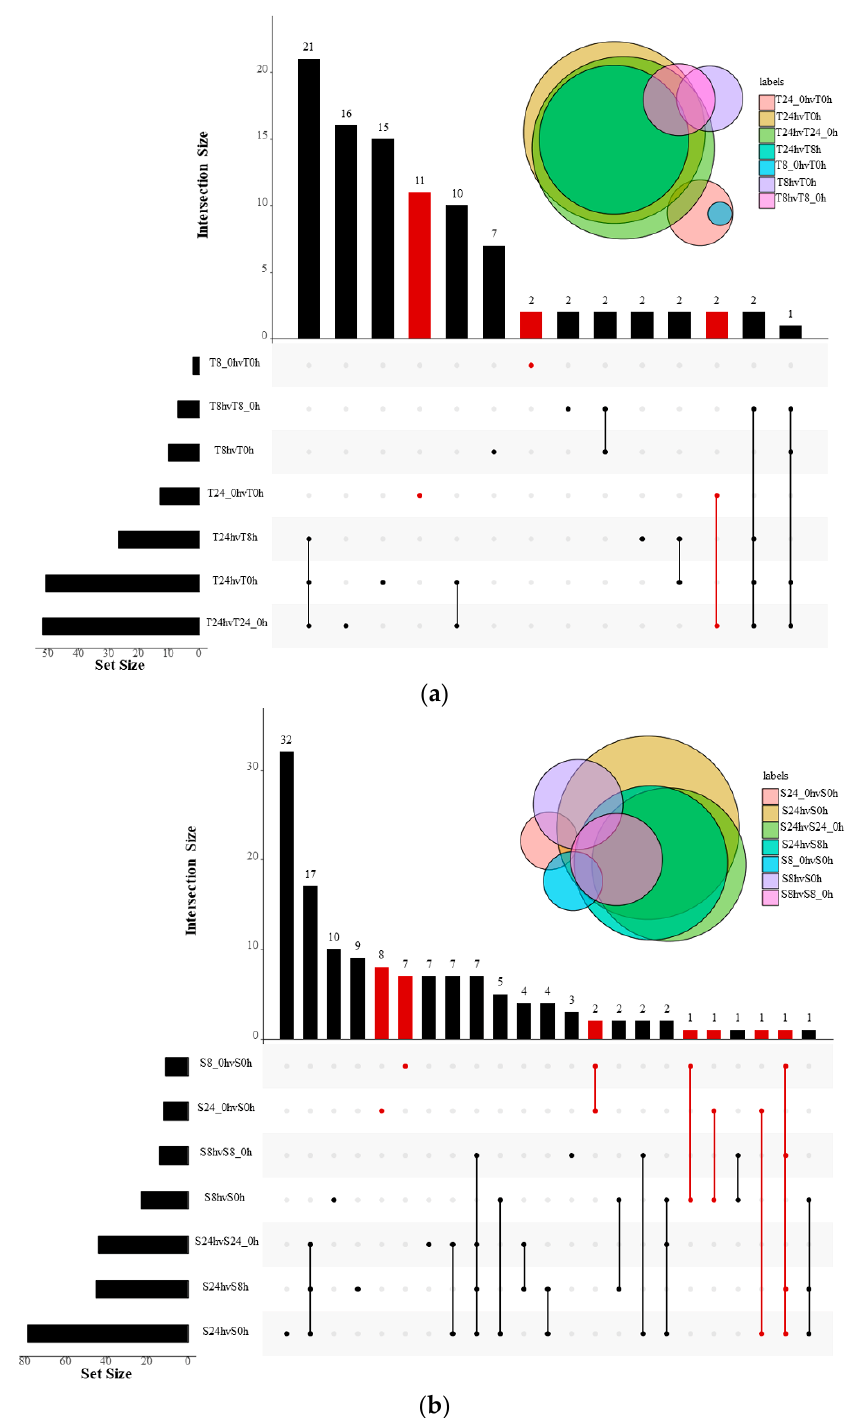
Figure 3. Al-responsive miRNAs in peanut. Upset of differentially expressed genes in response to 99-1507 ( a ) and ZH2 ( b ). UpSetR visualizes intersections of sets as a matrix, in which the rows represent the sets and the columns represent their intersections. Refer to Conway, J.R. et al. [25] for legend description. The element query (red) selects classified as deletions.